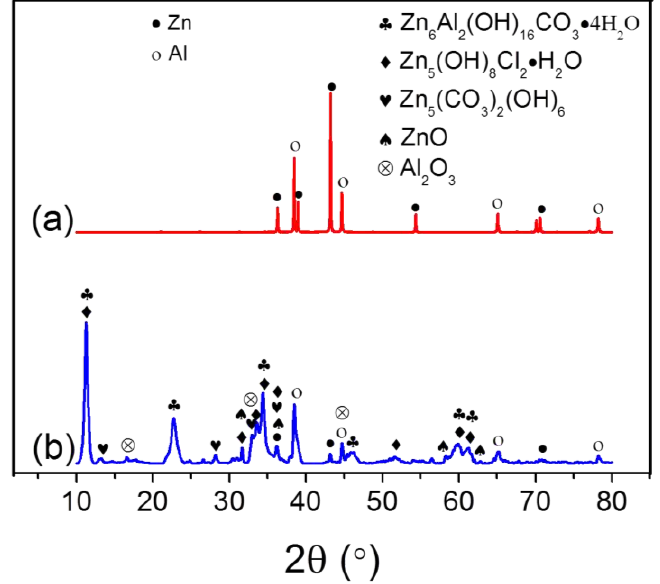
Figure 6. The XRD patterns of as-sprayed Zn-Al composite coating ( a ) and the corroded coating ( b ).